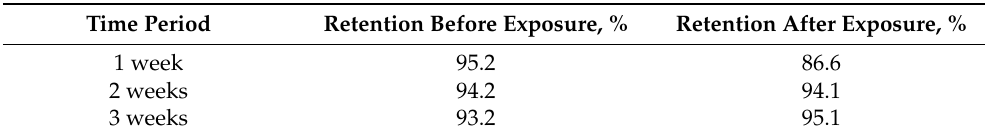
Table 3. Total carbon retentions of the membranes exposed to 60 vol% fresh DES in ethanol measured with PEG (4 kDa) solution of 300 ppm.